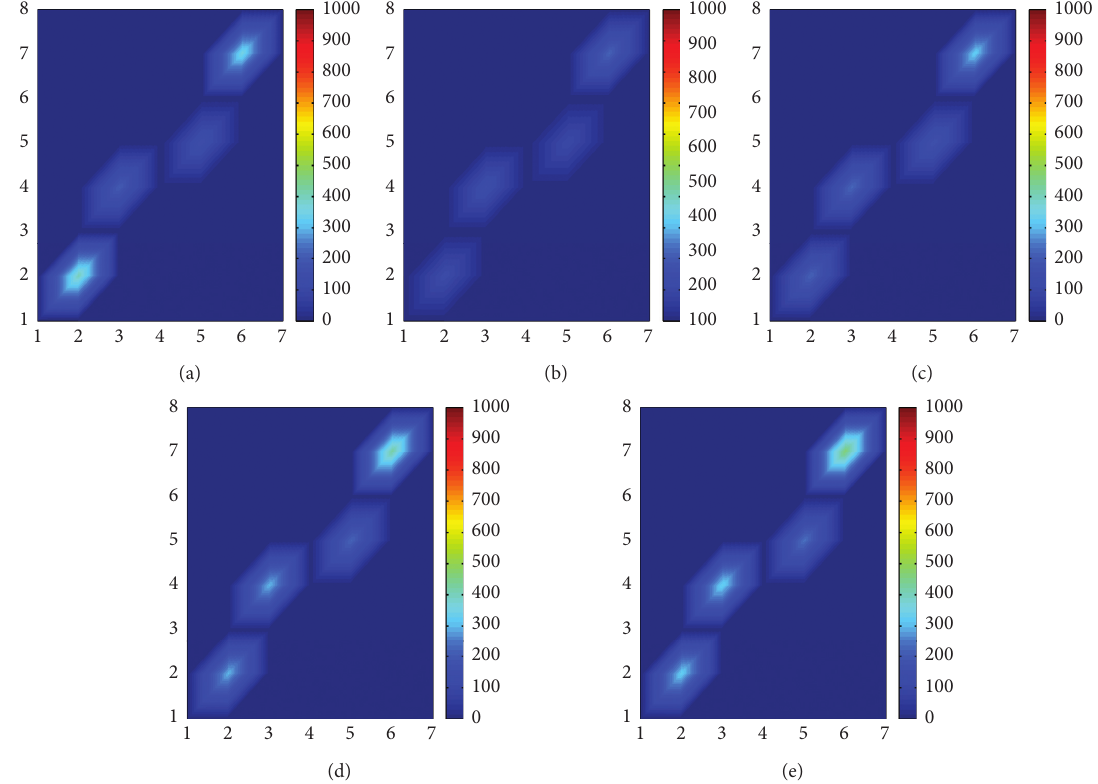
Figure 11: The biomass of middle predator behavior within Ω with control u C pq and v C pq . (a) t � 0. (b) t � 50. (c) t � 100. (d) t � 150. (e) t � 200.